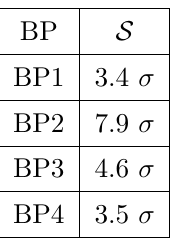
Table 4 . Signal signi(cid:12)cance for the benchmark points at 14 TeV with L = 3000 fb (cid:0) 1 for case I. (cid:15) Cut 4: transverse mass M > 550 T